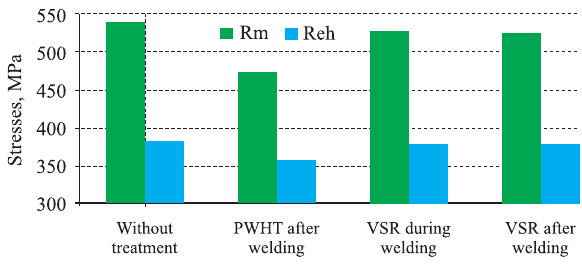
Fig. 6. The tensile test results